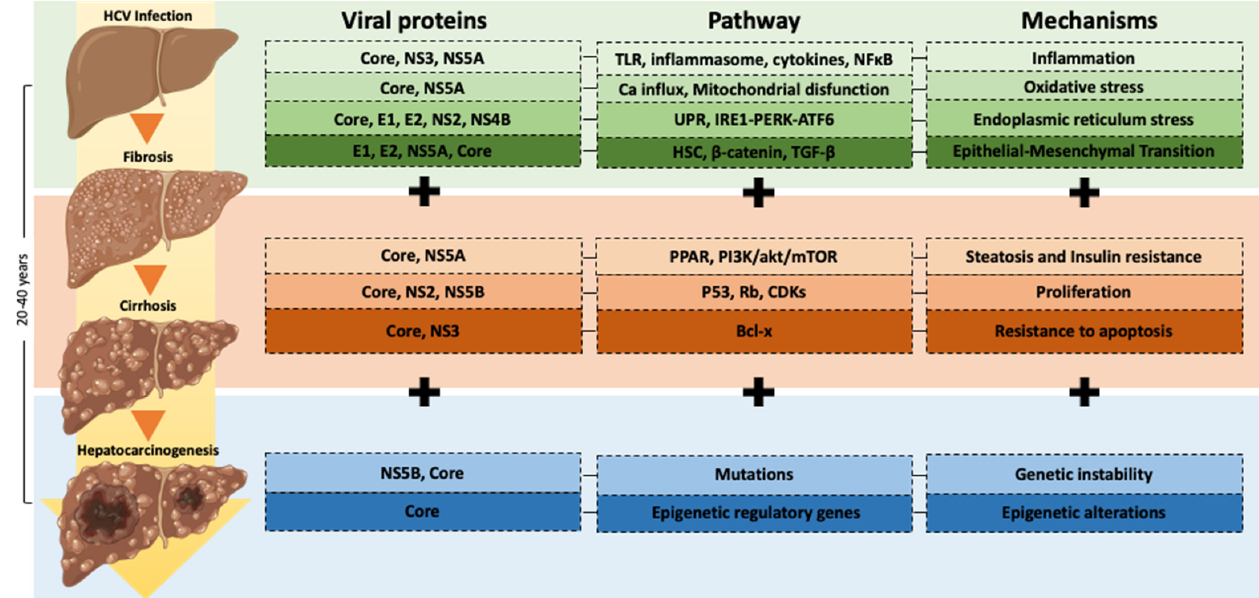
Figure 1. Molecular mechanisms implicated in hepatocarcinogenesis progression induced by HCV infection. The progression of HCV-infection-associated hepatocarcinogenesis involves diverse molecular mechanisms such as chronic inflammation, oxidative stress, endoplasmic reticulum stress, epithelial-mesenchymal transition, steatosis and insulin resistance, proliferation and apoptosis inhibition, genetic instability, and epigenetic alterations. Each mechanism has a specific molecular pathway regulated by viral HCV proteins.